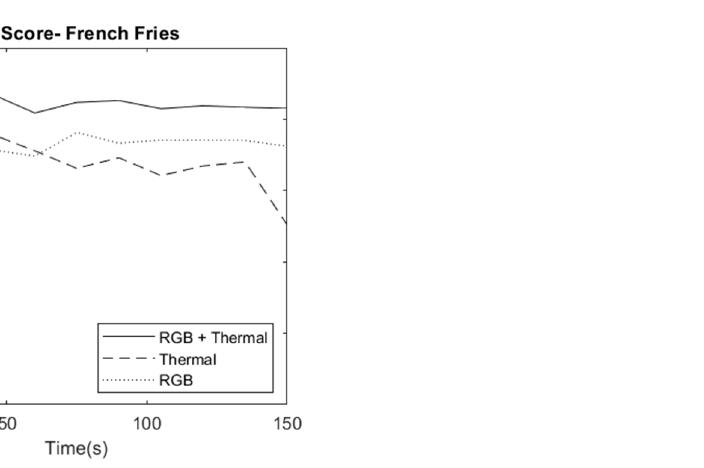
Figure 5. Segmentation Evaluation for the temporal dataset: F1 Score vs. Time (French Fries in Combination C1).